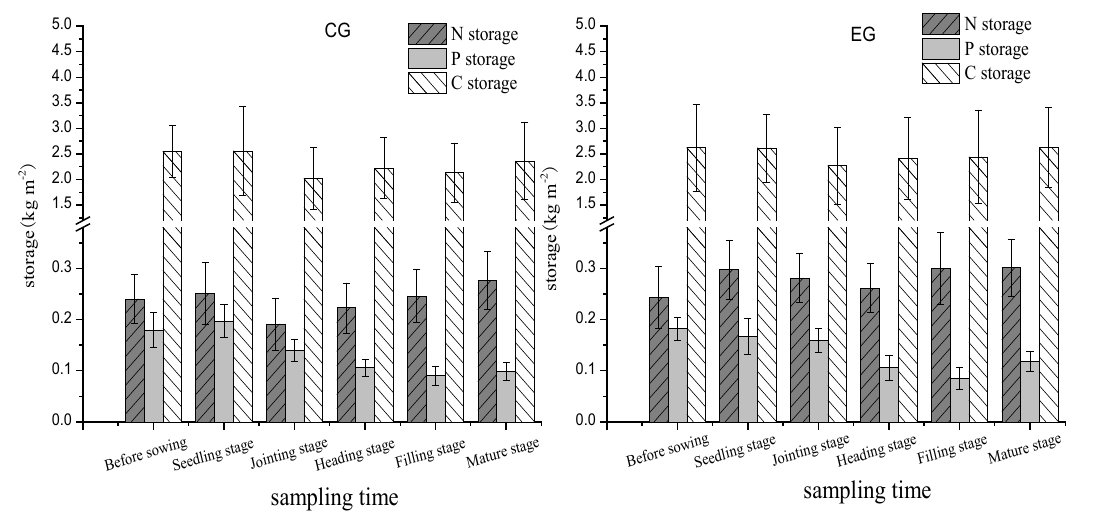
Figure 6: Temporal variation of N, P and C storage in the control group (CG) and the experimental group (EG) soils subject to poultry wastewater